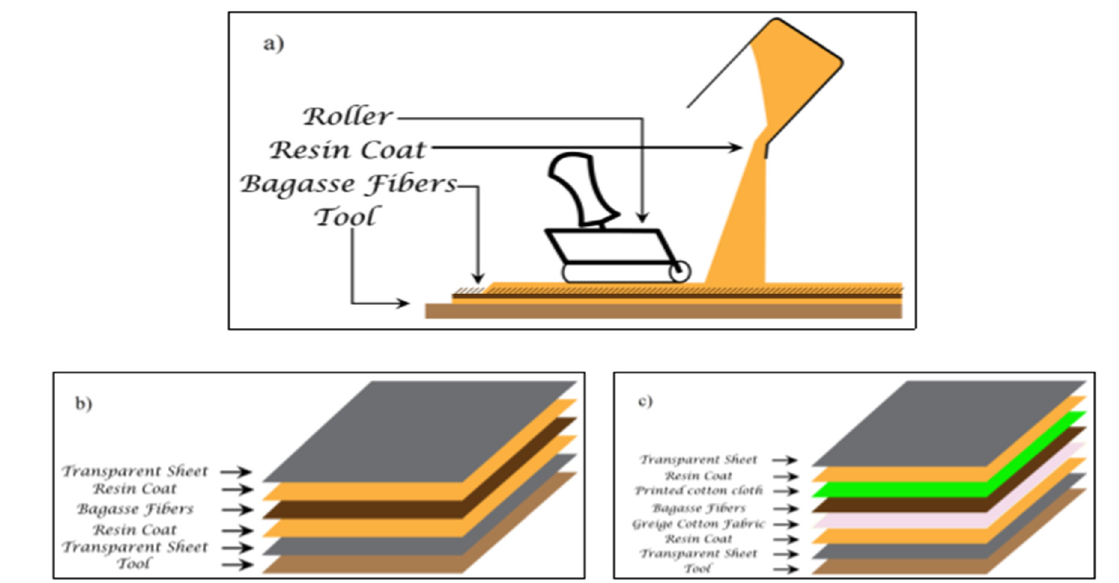
Fig. 1: Schematic layout of; a) Composite manufacturing process; b) Bagasse –reinforced composite; c) Bagasse- Cotton Fabric reinforced Composite